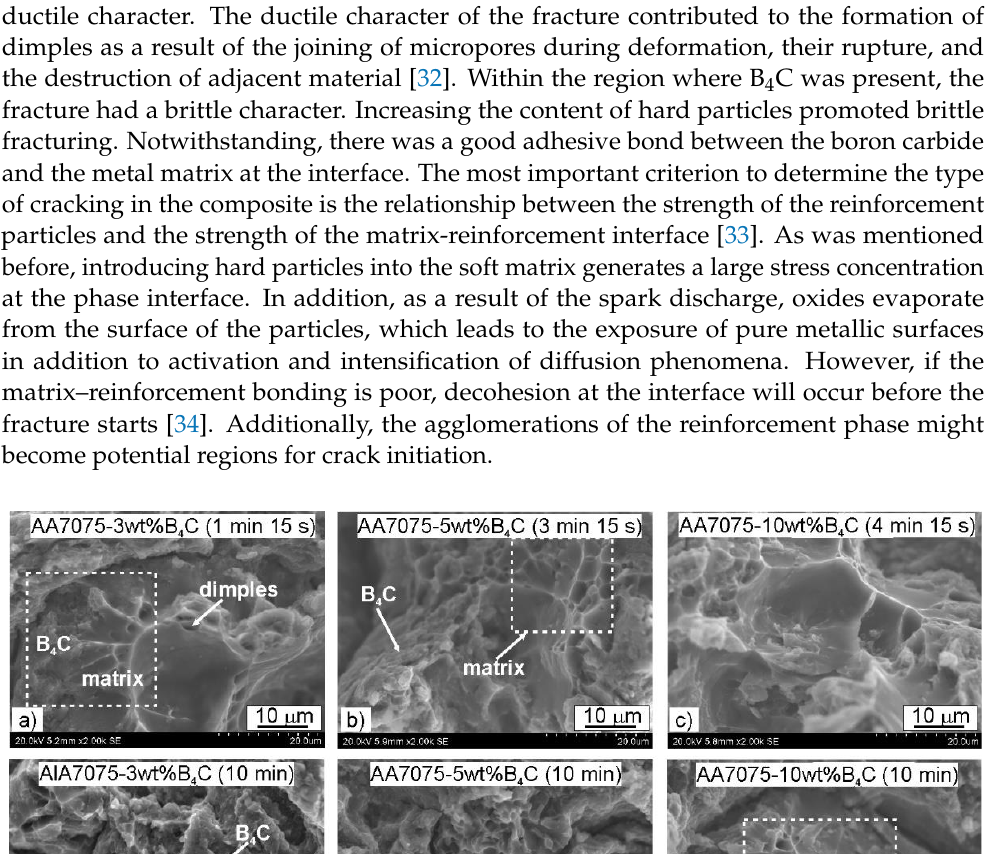
Figure 8. Flexural strength of AA7075-B 4 C composites spark plasma sintered at various holding times.